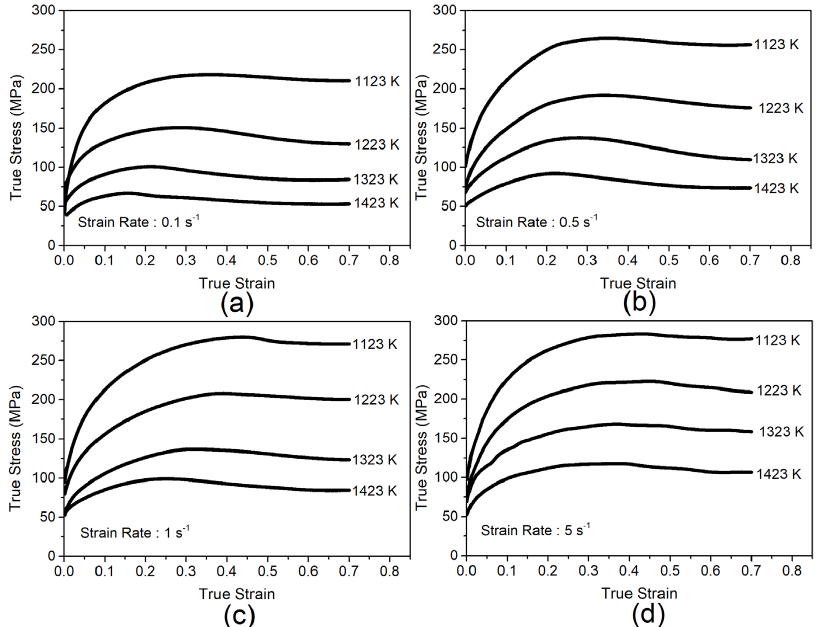
Figure 3. True Stress versus True Strain curves of studied steel at four different strain rates and temperatures (a) 0.1 s -1 , (b) 0.5 s -1 , (c) 1 s -1 , (d) 5 s -1 .